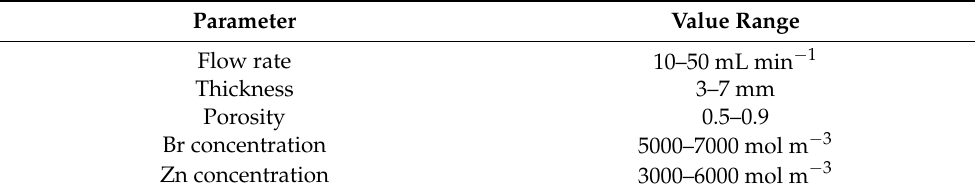
Table 8. The range of values of the parameters used in this work.